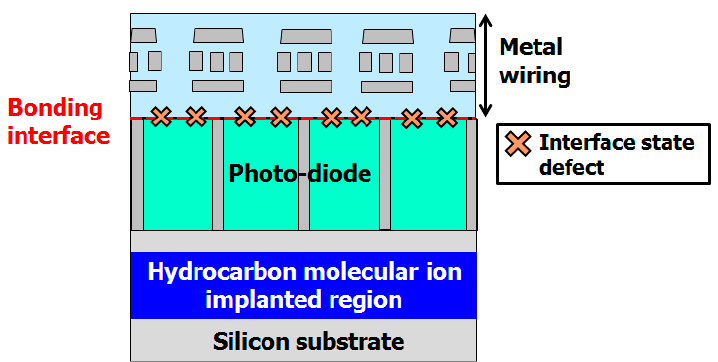
Figure 17. Gettering technology design of back-side-illuminated CMOS image sensors.